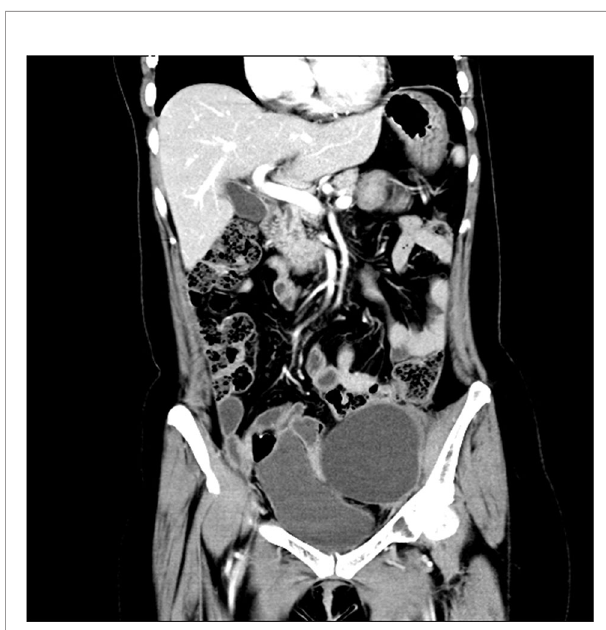
FIGURE 4 | Pelvic MRI on June 5, 2020. No recurrence was